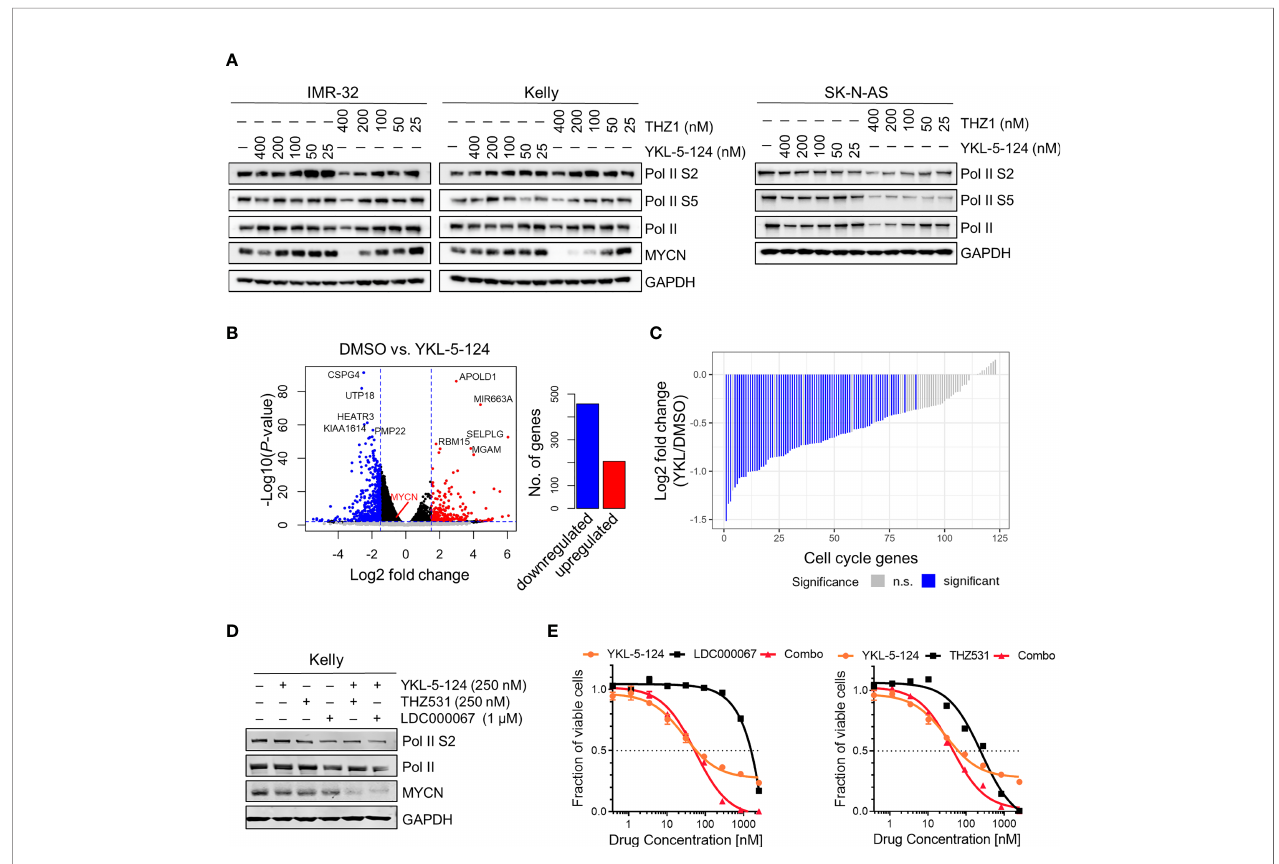
FIGURE 2 | YKL-5-124 does not induce global transcription downregulation in NB cells. (A) WB analysis of RNA Pol II phosphorylation and MYCN levels in NB cells following treatment with THZ1 and YKL-5-124 at the indicated doses for 6 h. (B) Volcano plot representation of differentially expressed genes following treatment with YKL-5-124 100 nM for 4 h ( left ). Fold change is represented in log2 scale (x-axis) and the − log10 P -value depicted on the y-axis (FDR < 0.01 and log2 FC >1.5). Bar plot depicting the numbers of up- and downregulated genes ( right ). (C) Waterfall plot depicting the log2 fold-change in gene expression of cell cycle genes in IMR-32 cells treated with YKL-5-124, as in (B) . (D) WB analysis of the indicated proteins in Kelly NB cells treated with YKL-5-124 in combination with LDC000067 or THZ531 at the indicated concentrations for 6 h. (E) Dose-response curves for Kelly cells treated with increasing concentrations of YKL-5-124 in combination with LDC000067, left (1:4 ratio) or THZ531, right (1:1 ratio) for 72h. Cytotoxicity is reported as percent cell viability relative to DMSO-treated cells. Data represent mean±SD; n